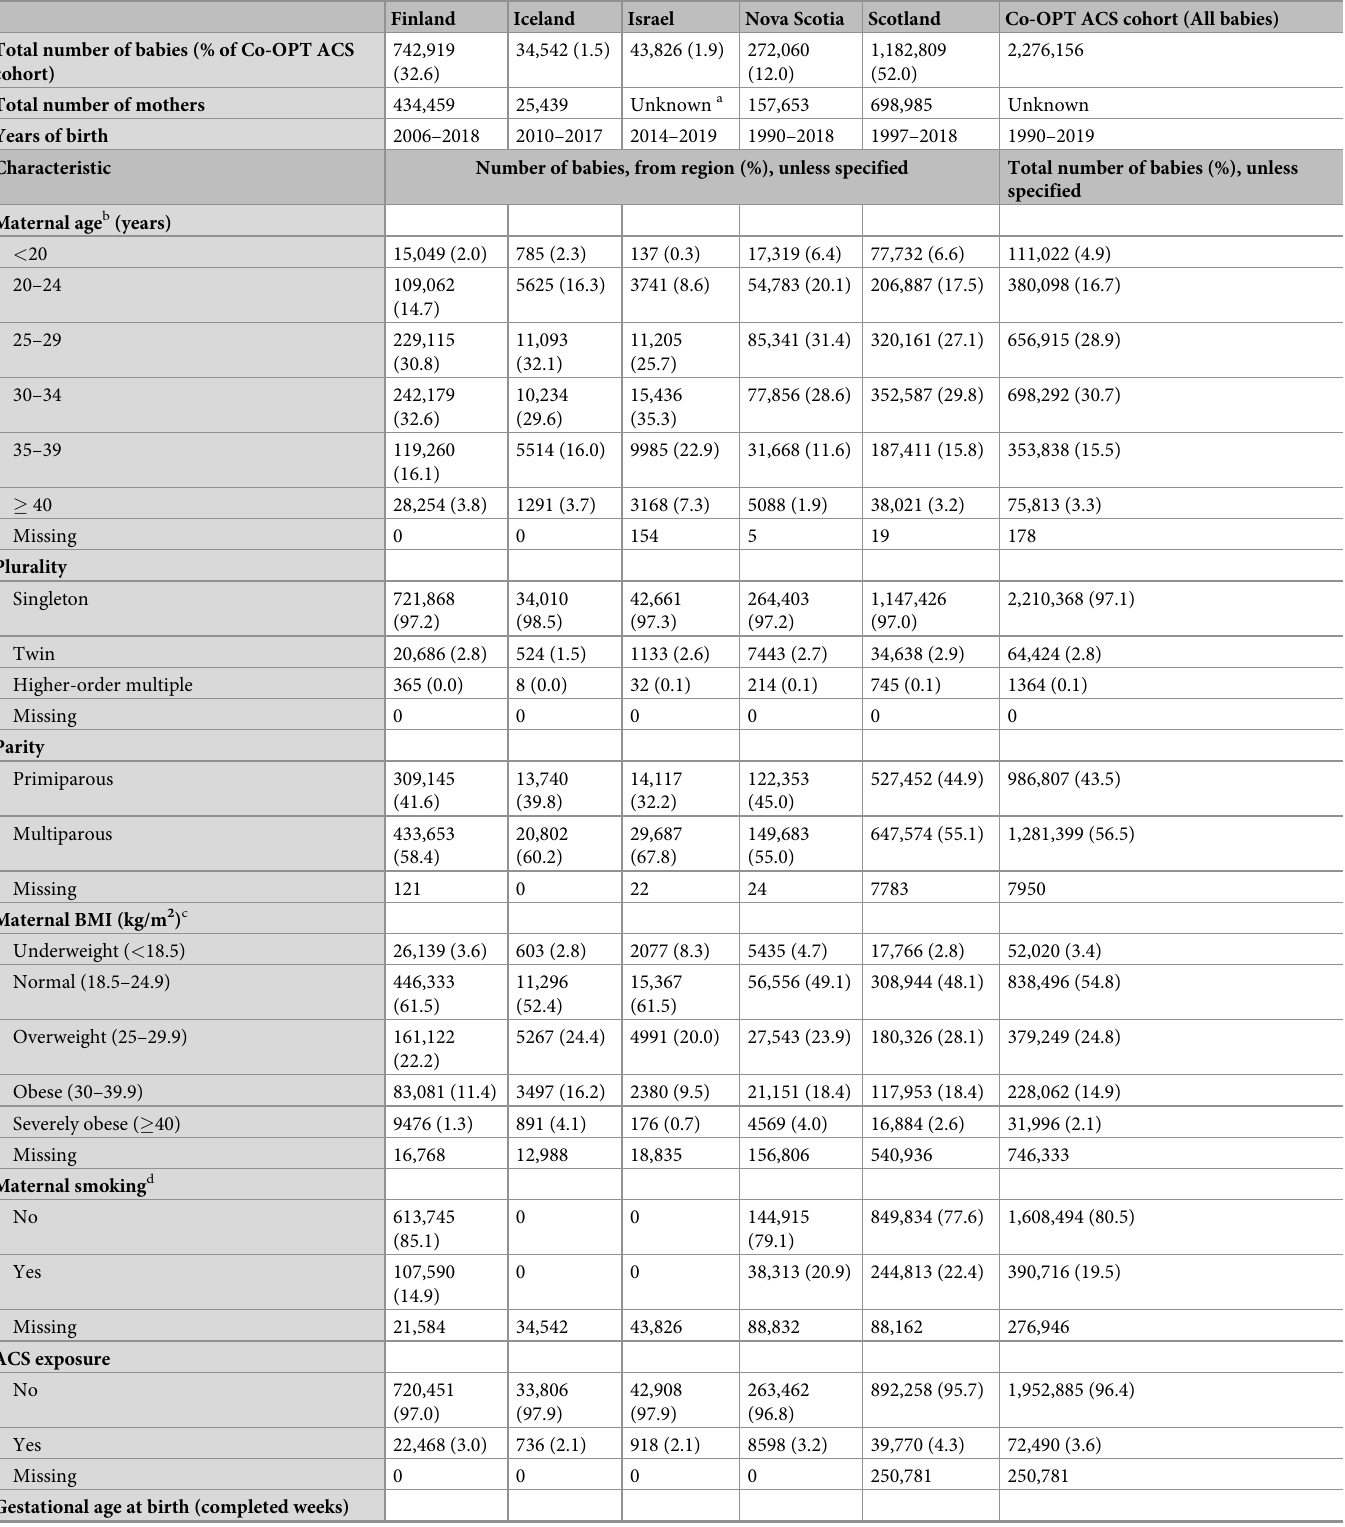
Table 4. Characteristics of the Co-OPT ACS cohort (n =